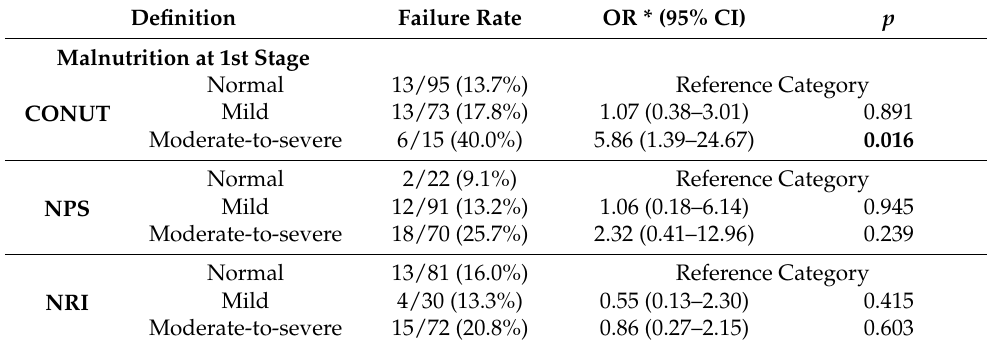
Table 4. The association between malnutrition and treatment failure due to direct